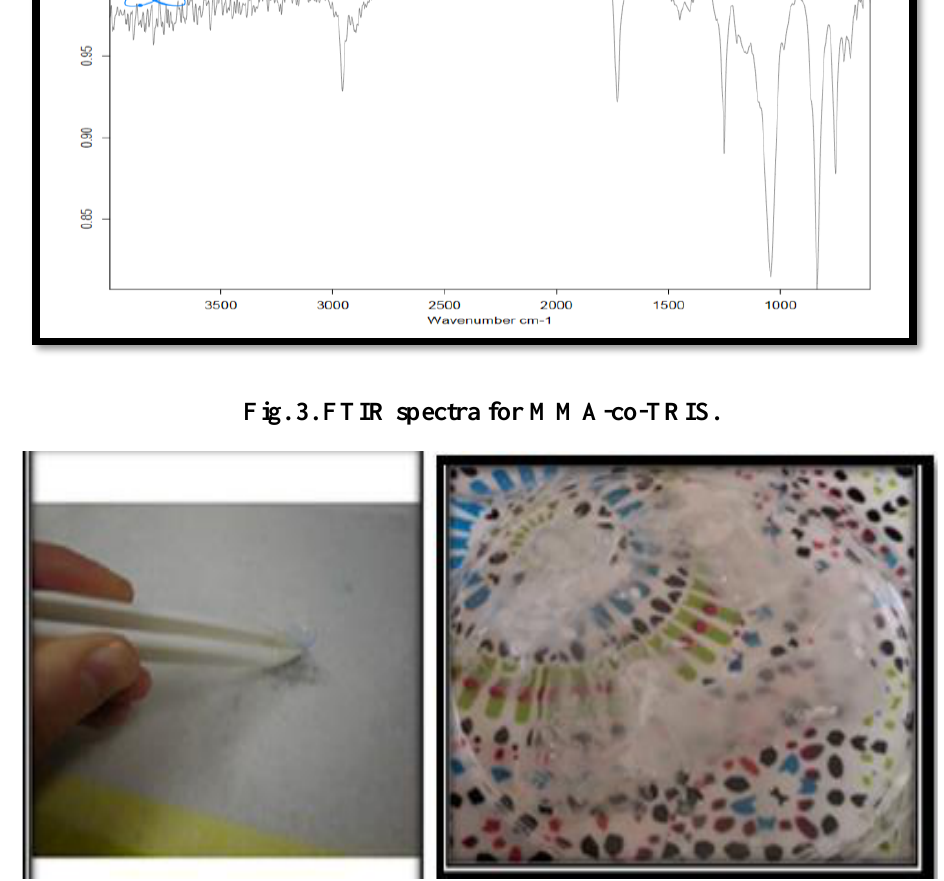
Fig. 4 .Preparation of TRIS-co-MMA contact